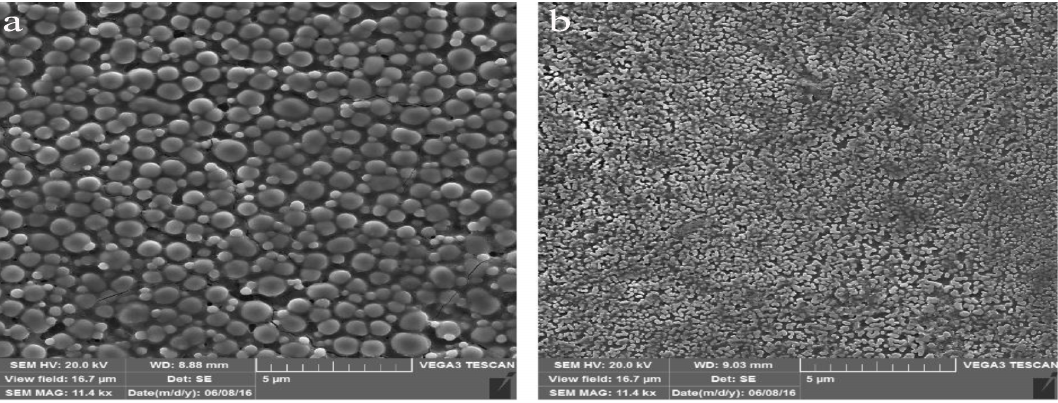
Fig. 2. SEM image of (a) Cs NPs (chitosan 1 mg/ml: TPP 0.5 mg/ml) (b) antibacterial- loaded Cs NPs (chitosan 0.1 mg/ml: TPP 0.5